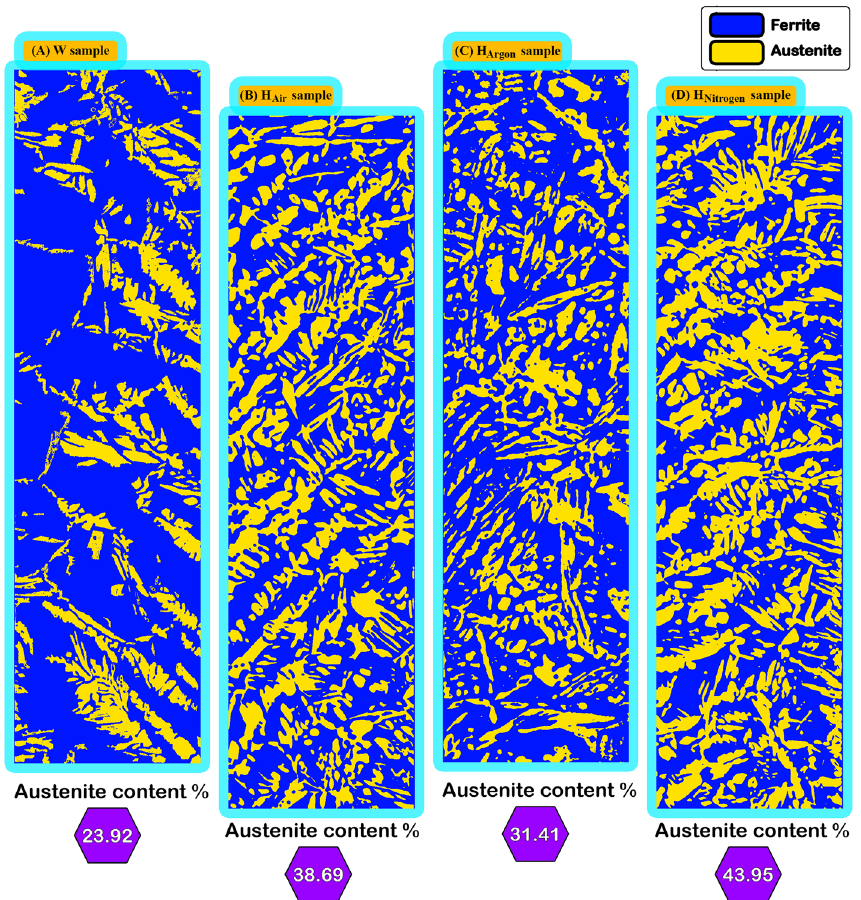
Figure 14. Volume fraction of austenite phase of one random image of heat affected zone of Samples (W, H Air , H Argon , and H Nitrogen